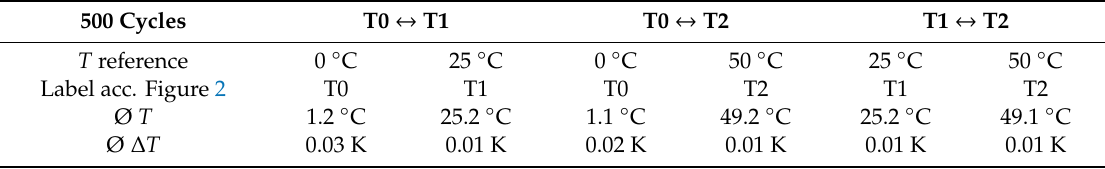
Table 3. Preliminary thermal cycling results of homogeneous transient setups (HT) measured at the central position between each pair of cell holder plates during steady-state sections.